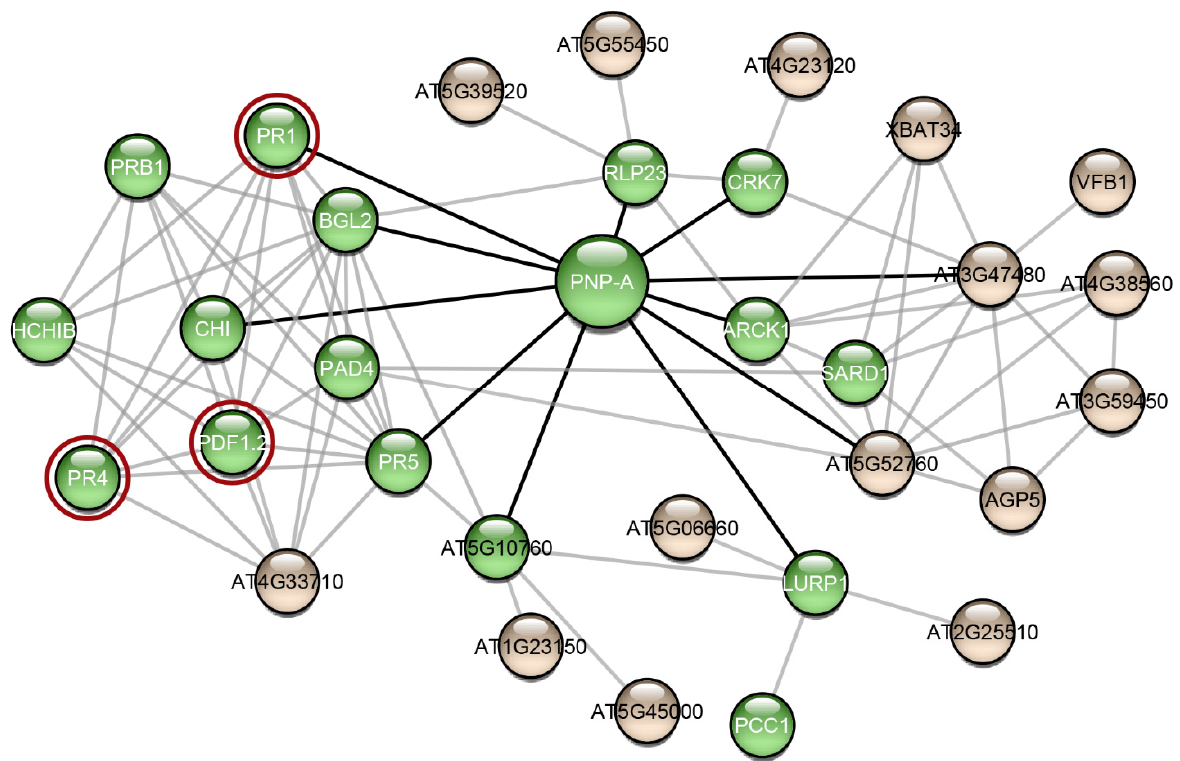
Figure 5. The interaction network of AtPNP-A. Interaction data for the creation of this network were gathered from the publicly available database STRING [57]. The network was visualized using Cytoscape 3.7.2 [58], a freely available platform for biological network visualization and analysis. The network consists of 32 nodes and 85 edges. Proteins are depicted as nodes and interactions as edges. Three of the proteins of the network (red circles) are associated with amyloid-forming proteins. Green-colored nodes are proteins that functional enrichment analysis indicated their association with defense responses. Black-colored edges are the interactions of AtPNP-A and grey-colored edges are the interactions of the AtPNP-A first neighbors.